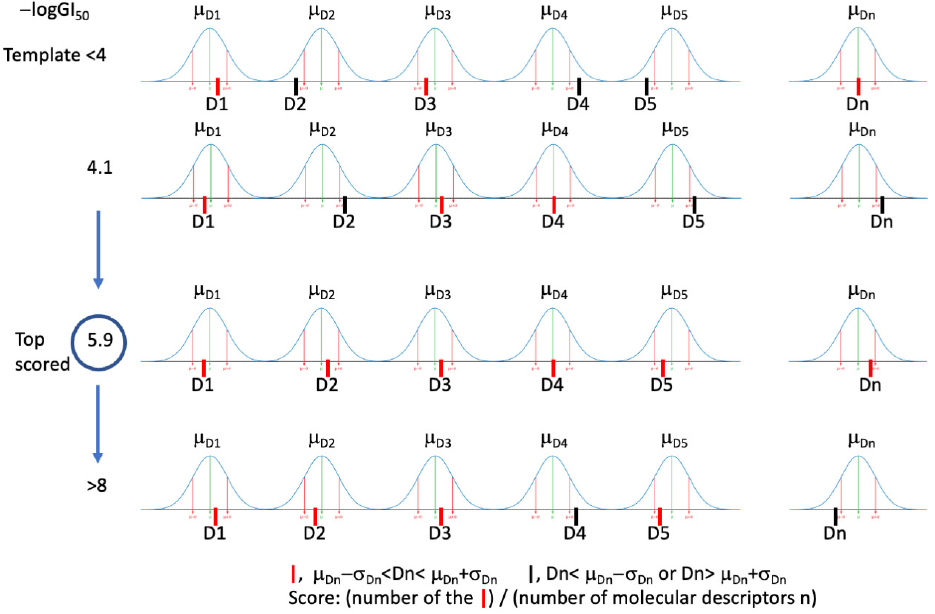
Figure 4. Graphical representation of GI 50 prediction by the CL module for a cell line. D1, D2 . . . Dn: molecular descriptors values for the input